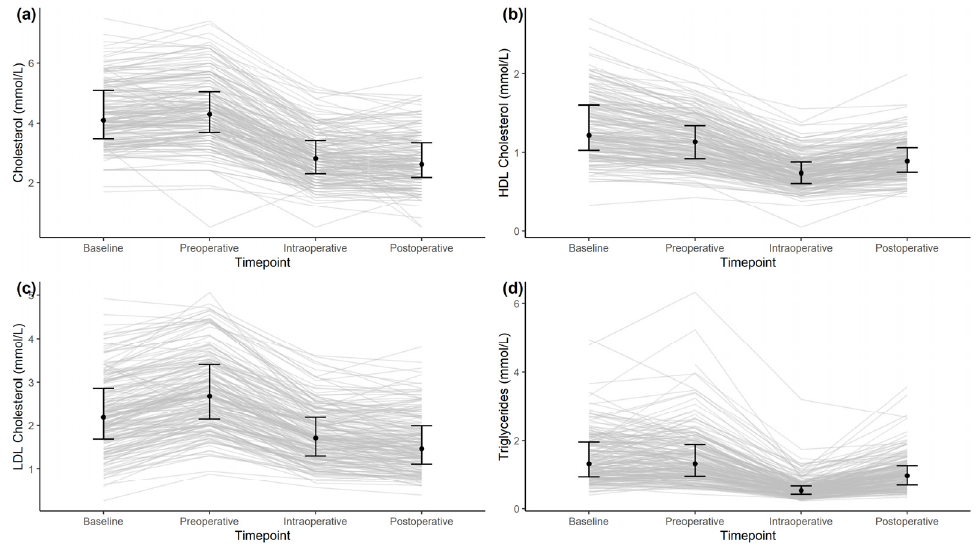
Figure 1. Time series of cholesterol ( a ), HDL-C ( b ), LDL-C ( c ), and triglycerides ( d ) for the baseline, pre-operative, intra-operative, and post-operative time points. Shown are medians and interquartile ranges at the different time points (black dots and black lines) and time series of individual patients (grey lines).